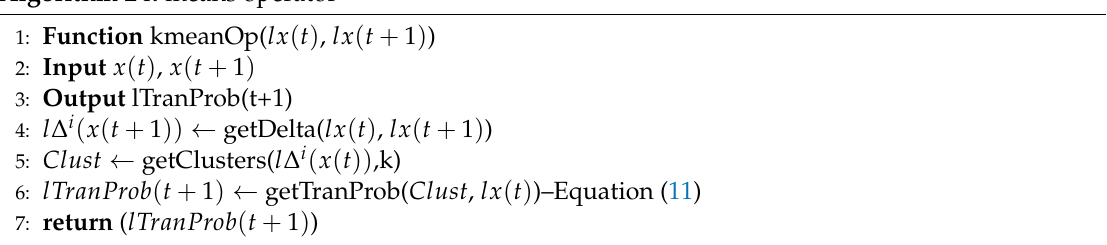
Algorithm 2 k-means operator